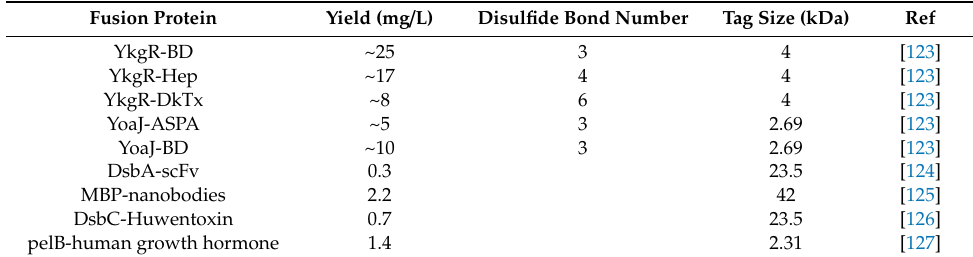
Table 7. Comparison of yields of proteins tagged with different signal peptides produced in the periplasm of E. coli .